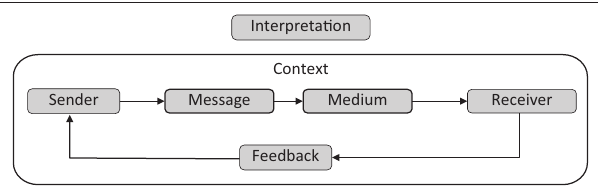
FIGURE 1: Components of